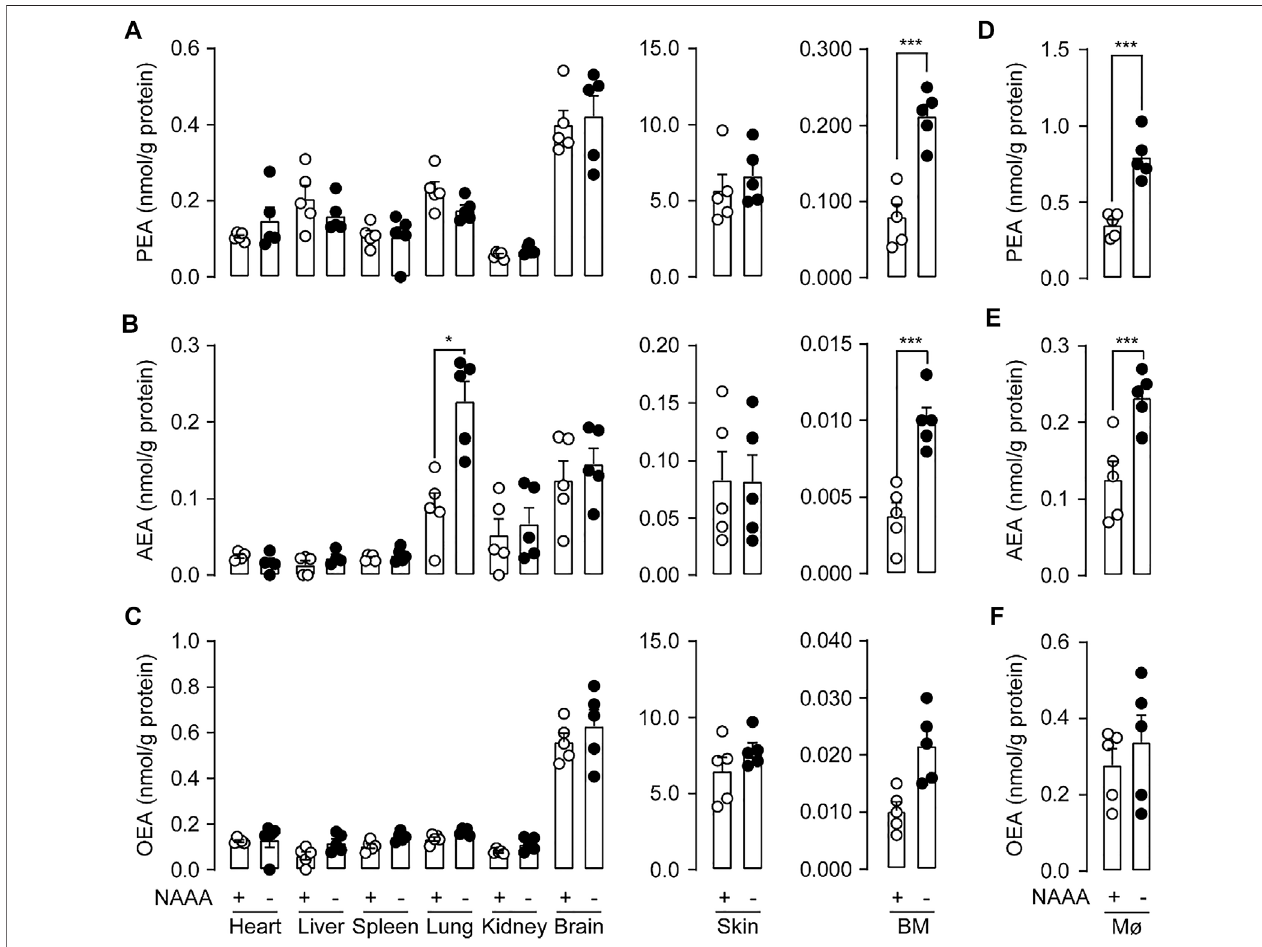
FIGURE 2 | Genetic inactivation of NAAA impairs FAEs levels in vivo . PEA (A,D) , AEA (B,E) and OEA (C,F) levels in various organs and bone marrow (BM) and primary macrophages (MØ) in WT and NAAA -/- mice. Data are expressed as mean ± SEM ( n (cid:1) 5). ns., p > 0.05; *, p < 0.05, ***, p < 0.001 by t test.